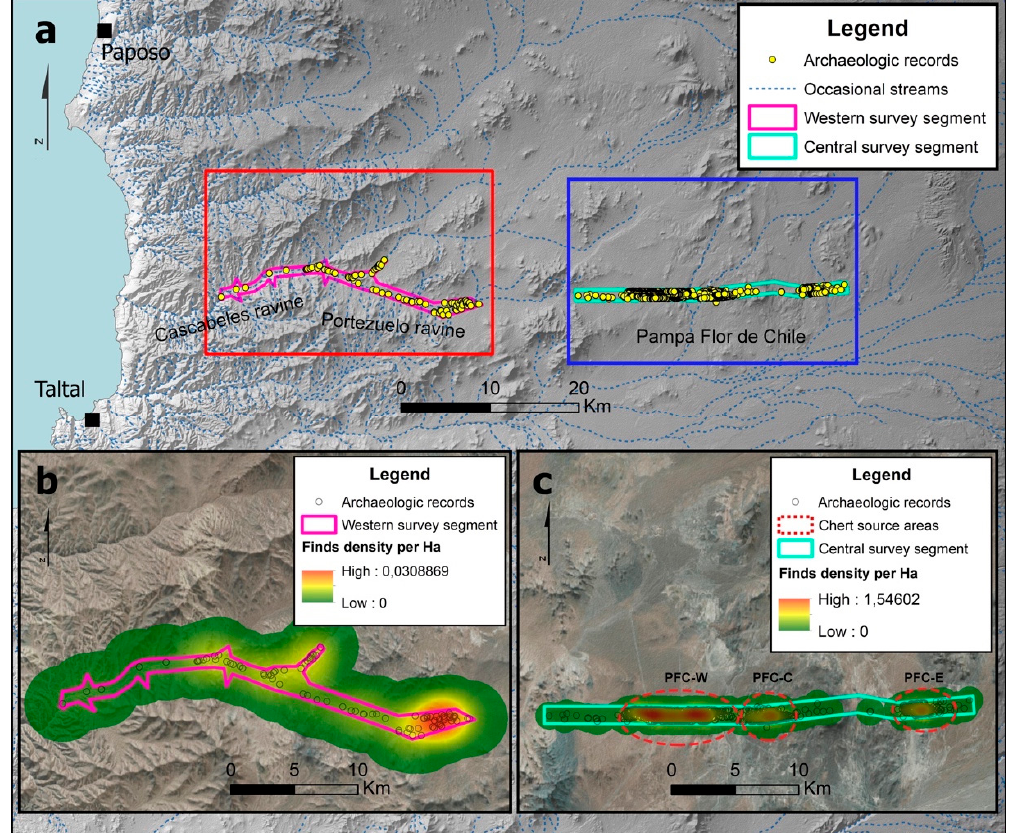
Figure 7. DEM of the study area showing the occasional streams (blue lines) and the locations with lithic scatters (yellow dots) recorded in the Western Segment (pink polygon) and Central Segment (light blue polygon) during systematic pedestrian surveys in the interior desert. Red box in ( a ) corresponds to a natural color composite ( b ) showing the Western Segment (pink polygon) and the archaeological finds (black circles) with their density per hectare. Blue box in ( a ) corresponds to a natural color composite ( c ) showing the Central Segment (light blue polygon); the archaeological finds (black circles) with their density per hectare; and the chert source areas Pampa Flor de Chile West, Center, and East (red circles).